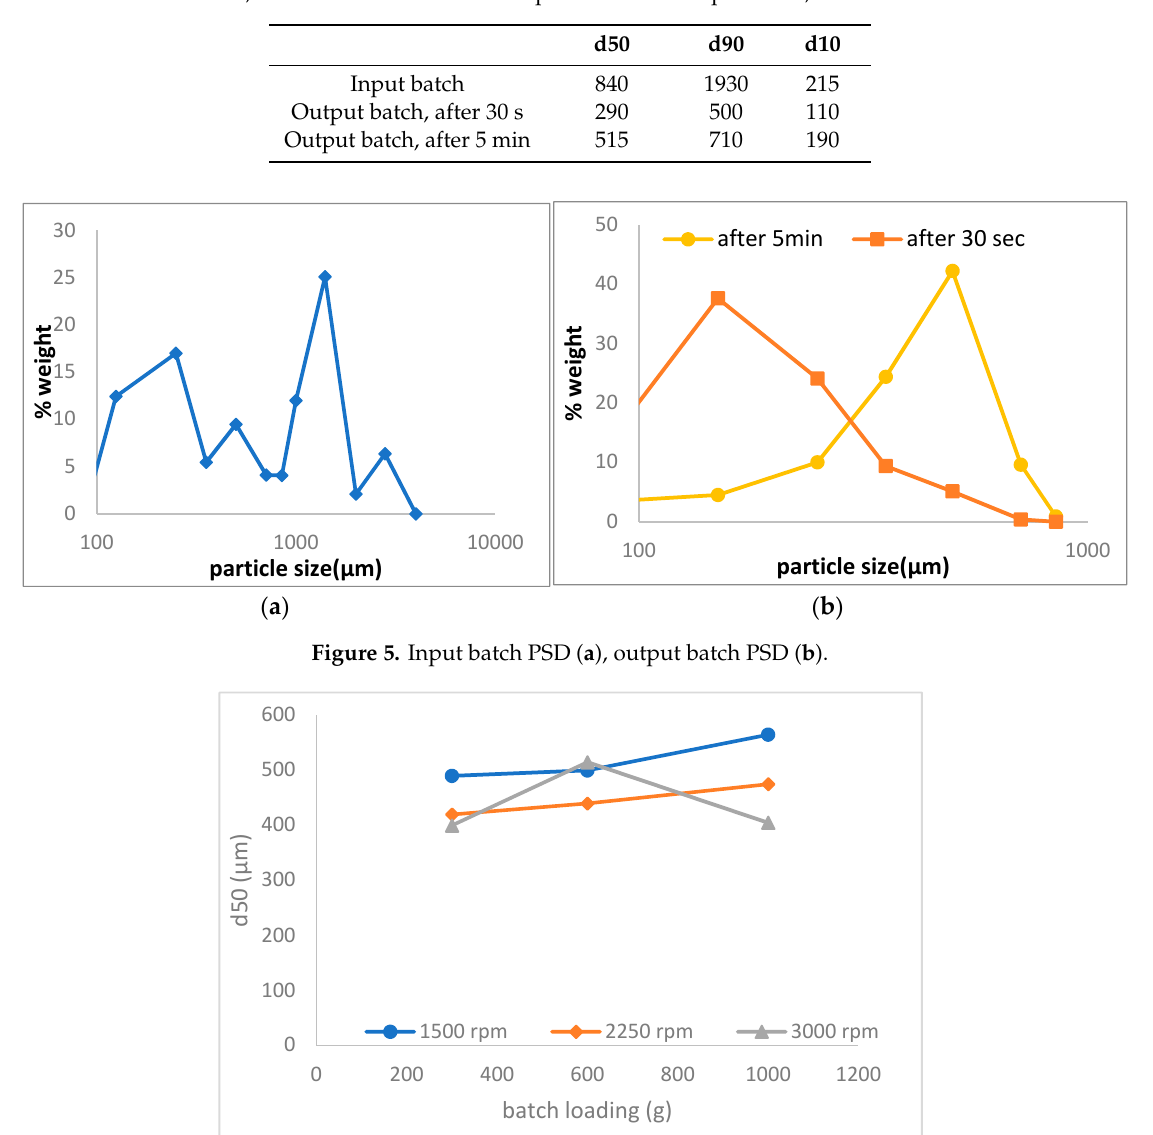
Table 4. d10, d50 and d90 values of the input batch and output batch, after 30 s and 5 min.